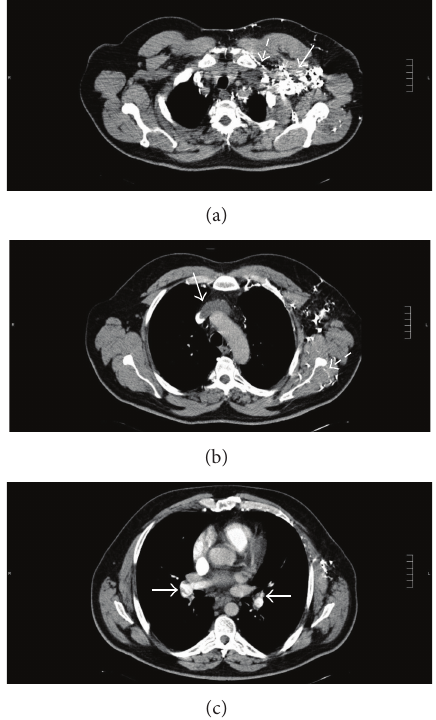
Figure 2: (a) Chest computed tomography angiogram. Thrombotic obstruction of the left brachiocephalic vein (dashed arrow) with multiple collateral vessels near the left clavicle and in the upper left limb (full arrow). (b) Chest computed tomography angiogram. Extension of the left brachiocephalic vein thrombus into the supe- rior vena cava (full arrow). Collateral vessels are seen adjacent to the left clavicle and in the upper left limb (dashed arrow). (c) Chest computed tomography angiogram. Arterial thromboemboli in the pulmonary arteries (full